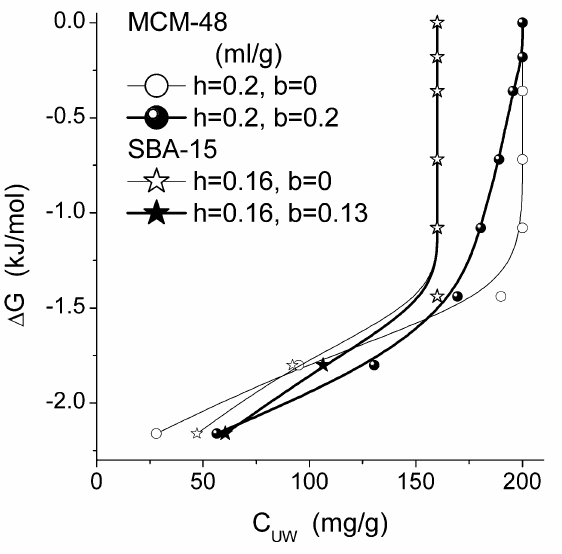
Fig. 4 Relationships between amounts of unfrozen water and changes in its Gibbs free energy for water and water/benzene adsorbed onto MCM-48 and